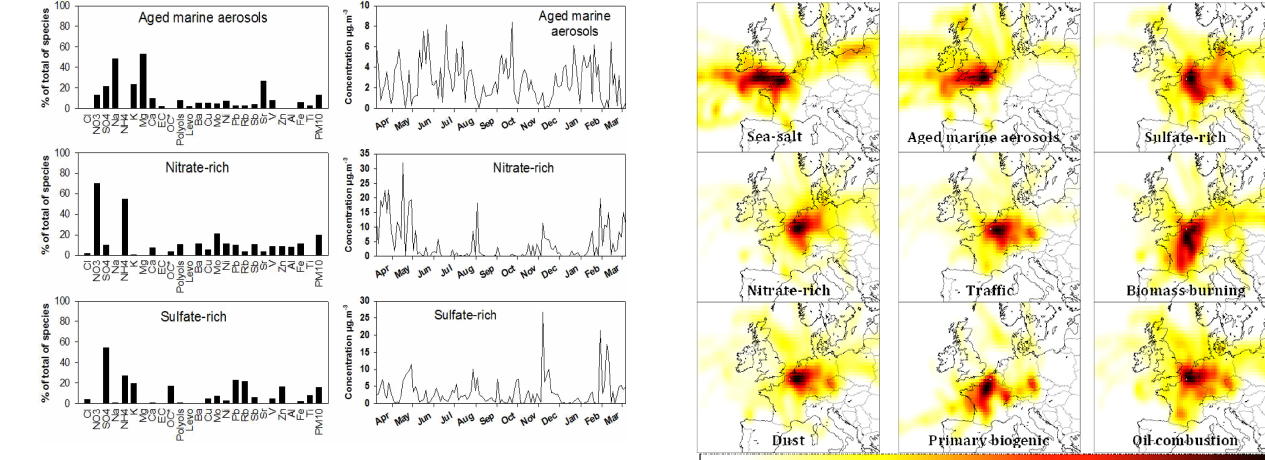
Fig. 6. Source profiles (left panels) and temporal evolutions (right panels) of contributions of secondary factors.